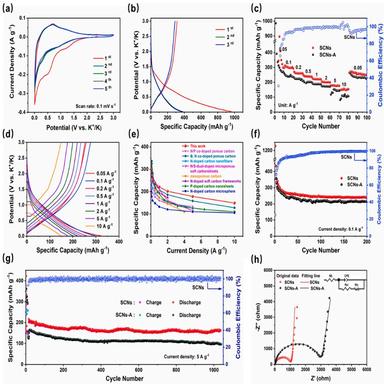
Electrochemical properties of the anodes in half-cells. a) CV curves at scan rate of 0.1 mV s − 1 , b) galvanostatic charge/discharge profiles of the first three cycles for SCNs electrode. c) Rate capabilities of SCNs and SCNs-A. d) Charge and discharge curves of SCNs at various current densities. e) Comparison of rate capability of SCNs electrode and other carbonaceous materials in PIBs. f) Cyclic property at 0.1 A g− 1 , g) long-term cycling performance at 5.0 A g− 1 , and h) Nyquist plots of SCNs and SCN